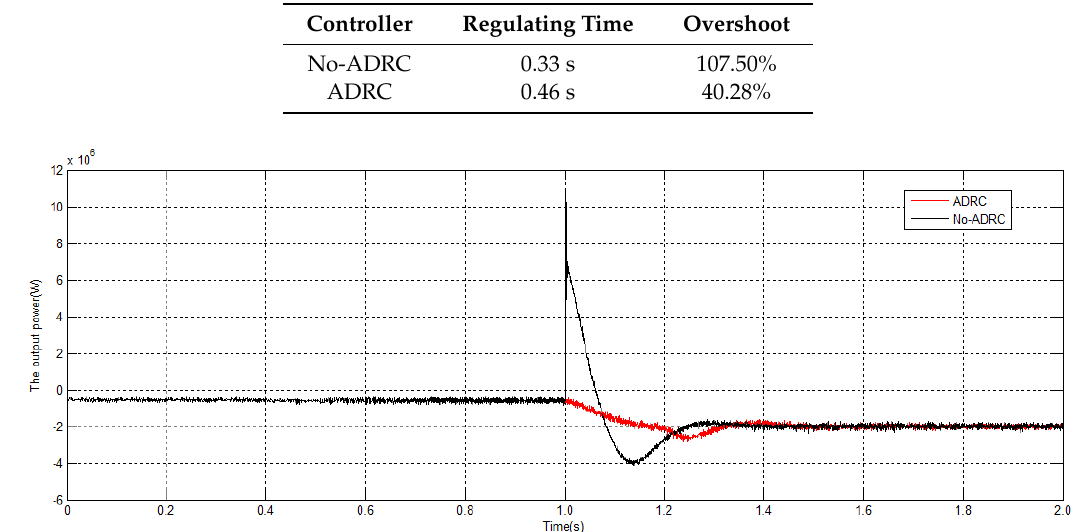
Figure 18. Simulation curve of the output power.